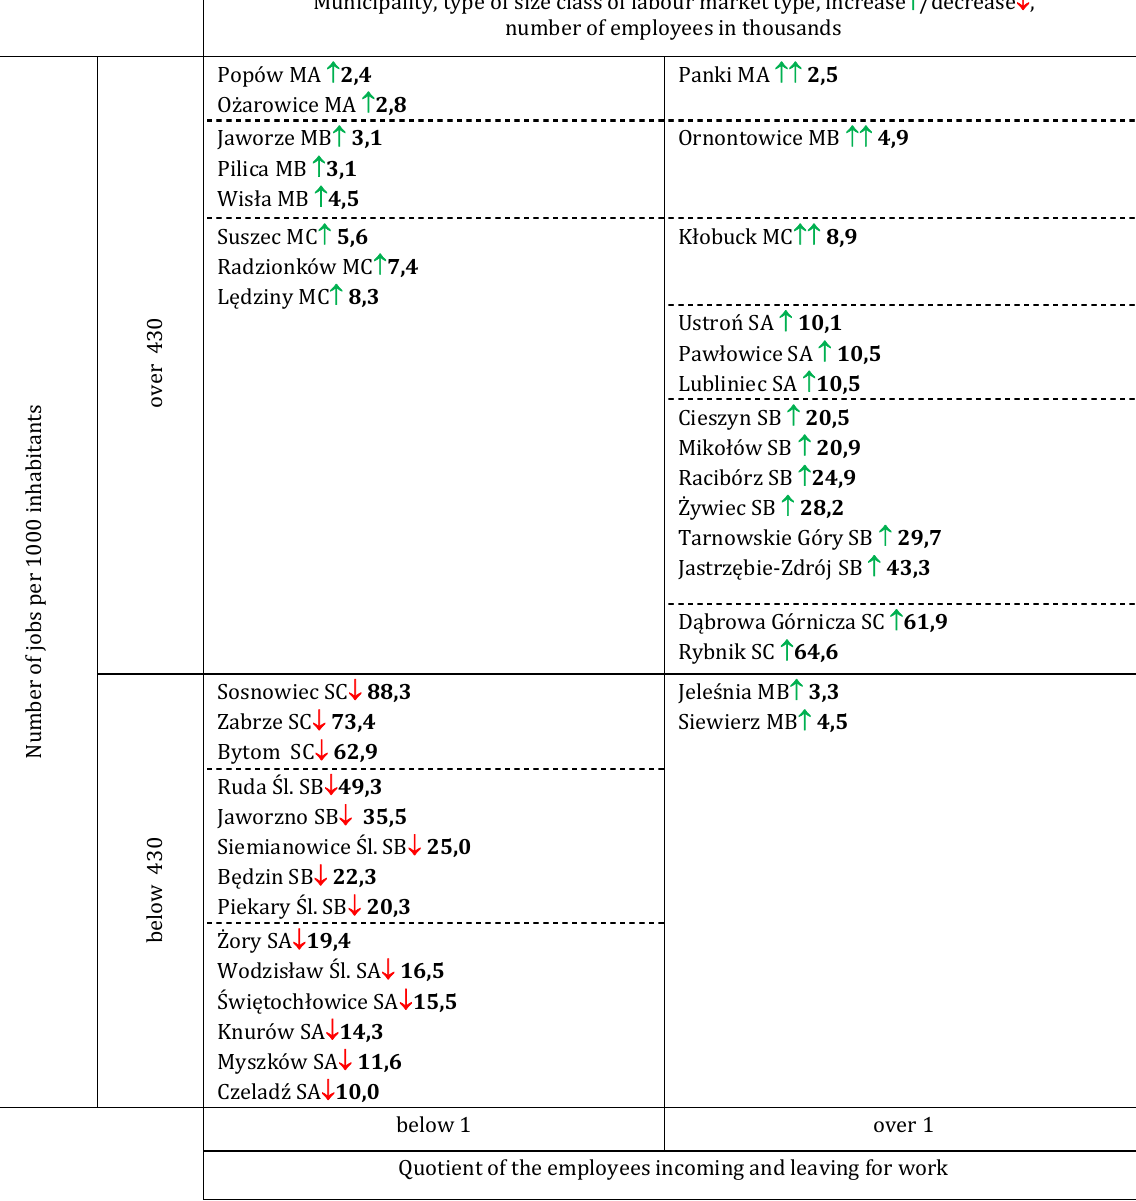
Table 2. Municipal labour markets, the parameters of which are not adequate to their size (marking of class size of labour markets in accordance with Fig. 1) Municipality, type of size class of labour market type, increase  /decrease  , number of employees in